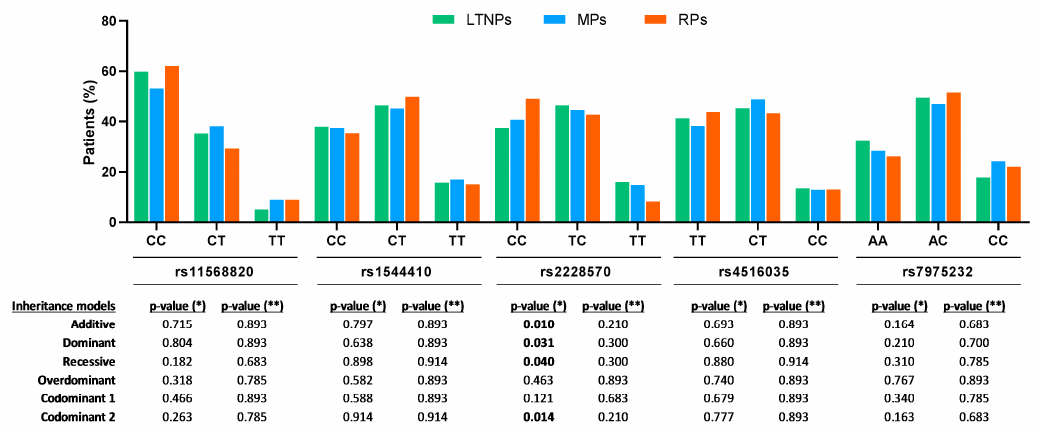
Figure 2. Genetic association of VDR polymorphisms, with distinct patterns of AIDS progression in HIV infected patients. p -values were calculated by the Mantel-Haenszel linear-by-linear association test. (*), raw p -values; (**), p -values corrected for multiple testing using the false discovery rate (FDR) with Benjamini and Hochberg procedure ( n = 30, multiple comparisons). VDR, vitamin D receptor; LTNPs, Long Term Non Progressors; MPs, Moderate Progressor; RPs, Rapid Progressor; Codominant 1, homozygous more frequent versus heterozygous; Codominant 2, more frequent homozygote versus less frequent homozygote.